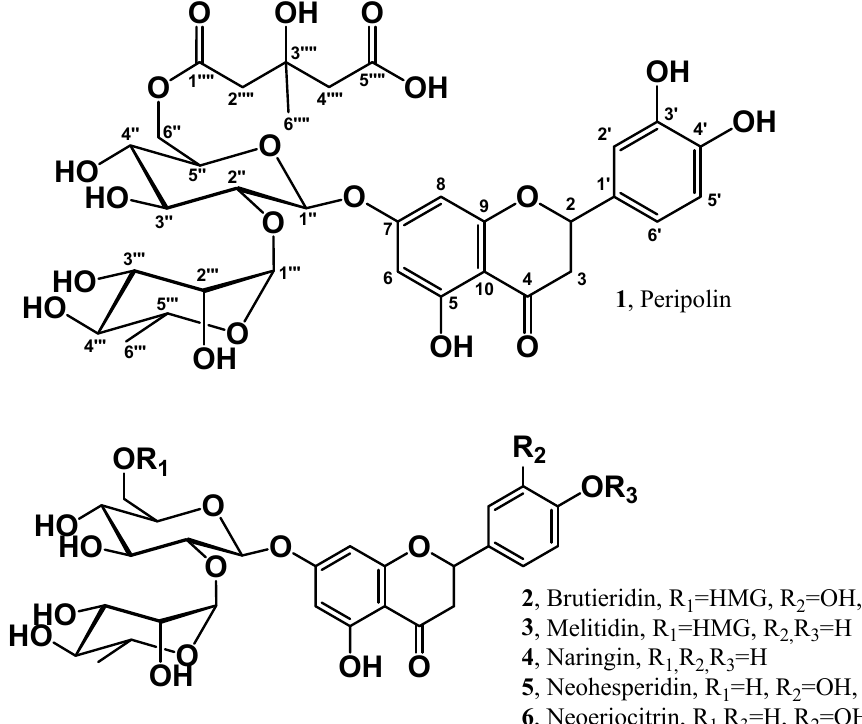
Figure 1. Structural formula of Peripolin and the main flavonoids from